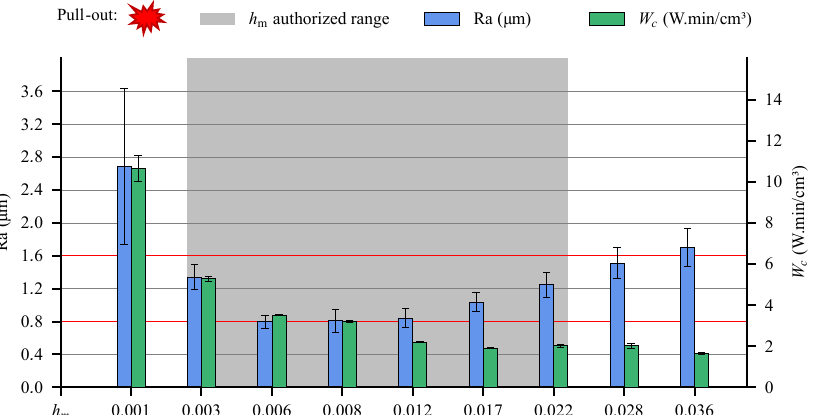
Figure 23. Evolution of the specific cutting energy (W · min/cm 3 ) and Ra (µm) of the composite tool for different h m (mm) with v c = 351 m/min, a p = 3 mm and a e = 0.5 mm No material pull-out was observed.